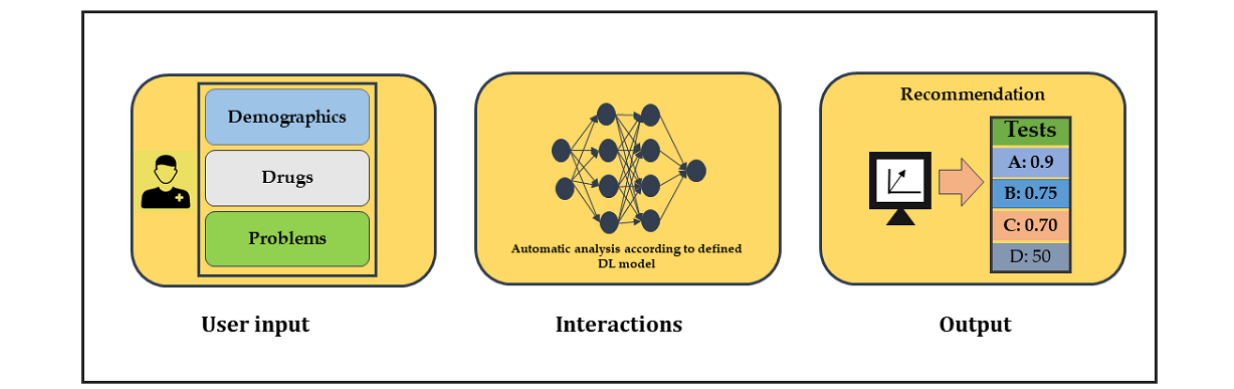
Figure 5. Proposed infographic of deep learning (DL)-based laboratory testing recommendation